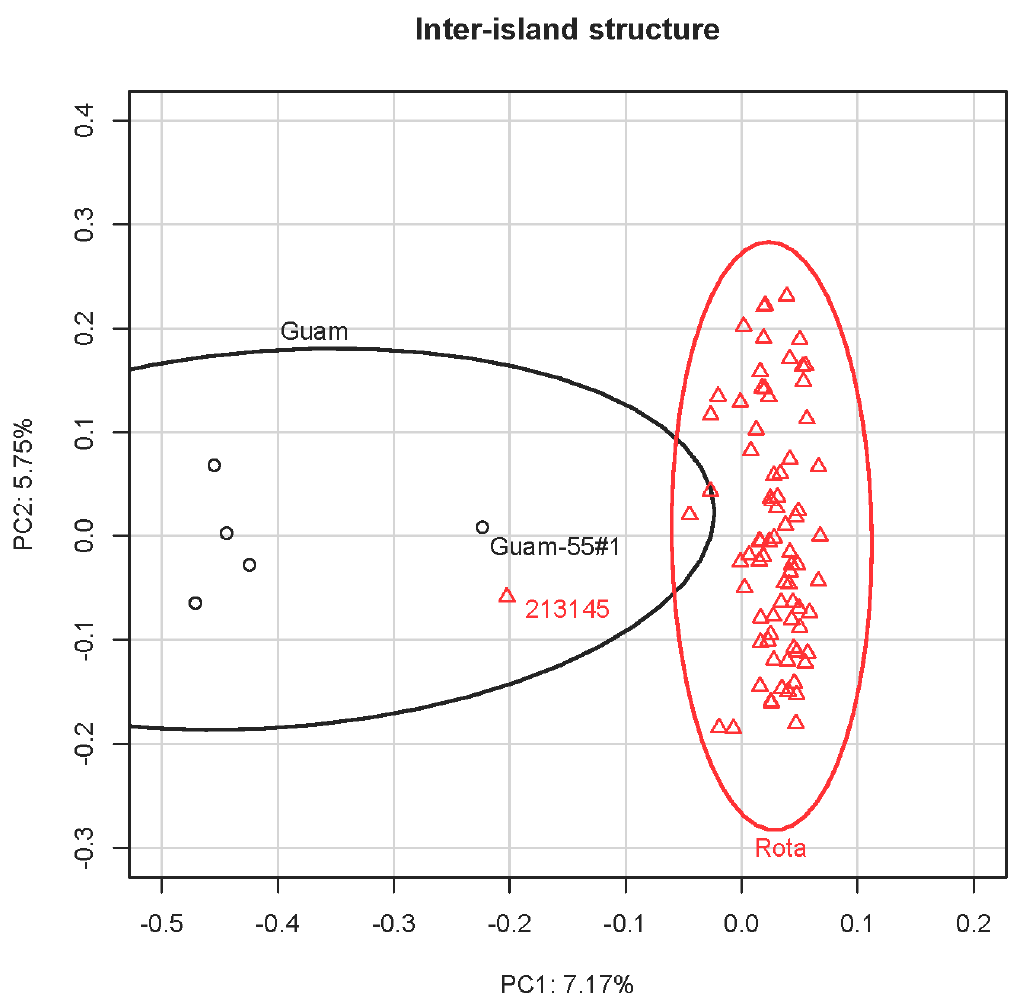
Figure 2. Principal Component Analysis (PCA) of Mariana Crows from Guam and Rota using 6741 SNVs. The 95% data ellipses clearly distinguish the populations from the two islands. Potentially (but see text for alternative interpretation) admixed individuals (Guam-55#1 and 213145) are denoted on the plot.